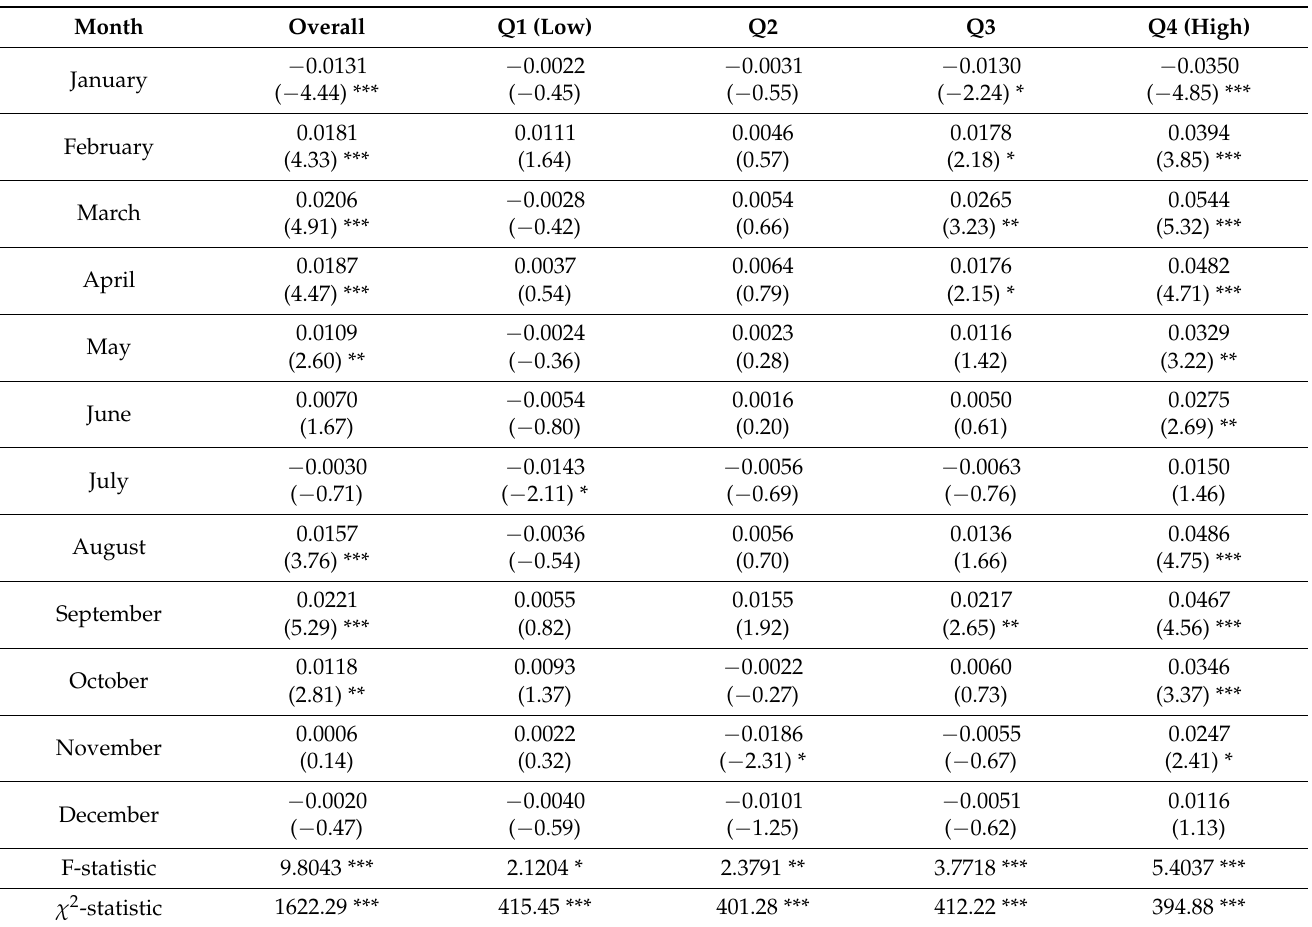
Table 3. Tests for monthly seasonal effects in excess returns with uncertainty quartiles. The table reports of OLS regressions for our sample of excess returns, which includes data from January 1997 through December 2018. The table reports estimates of seasonal dummy variables for the full sample as well as for quartiles based on the standard deviation of analysts’ forecasts scaled by price ( σ (FEPS)). Excess returns are computed using portfolio rankings indicated by beta. t -statistics appear below each coefficient estimate with asterisks indicating statistical significance. The final two rows report F-tests and χ 2 -tests of the null hypothesis of no difference across months. *, **, and *** indicate significance at the 10%, 5%, and 1% level,